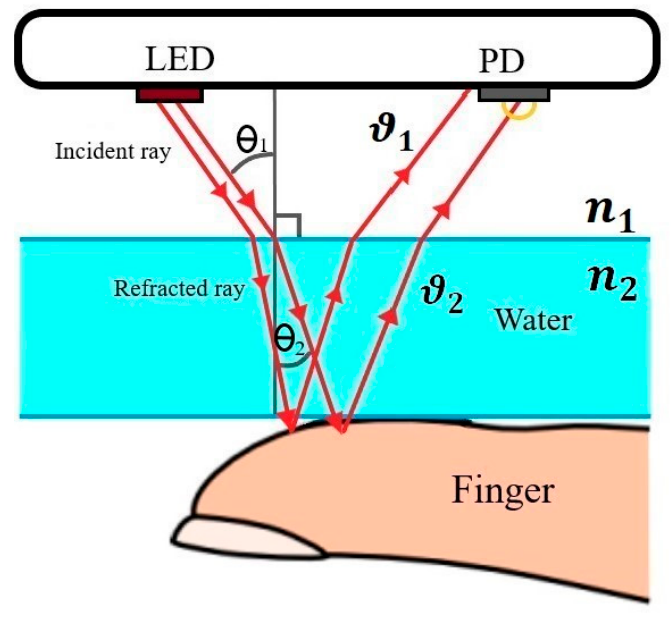
Figure 5. Refraction effect between water and air with the smartphone configuration with an LED emitter and the photodiode (PD) receiver sensor.